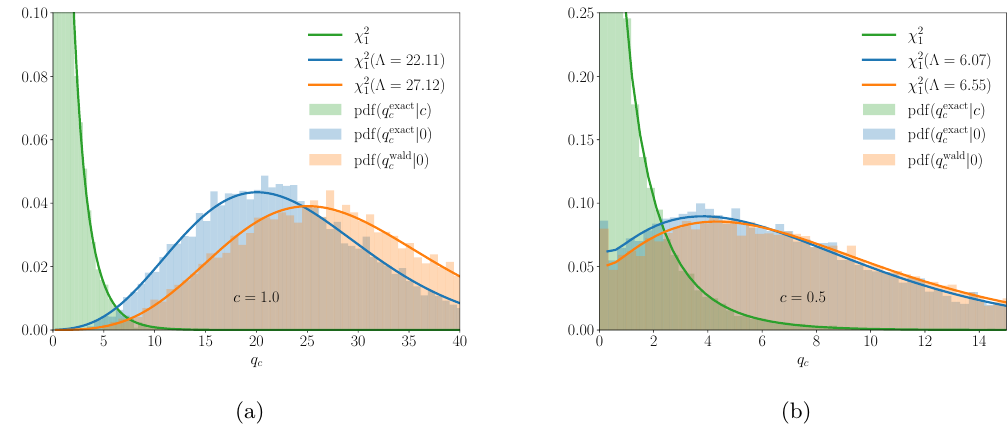
Figure 21. The distributions of q c under the EFT and the SM hypotheses for c = 1 . 0 (a) and c = 0 . 5 (b). The blue curve agrees well with the distribution pdf( q exact distribution of q c is well described by the non-central χ 2 evaluated with non-centrality parameter Λ A , unbinned . We notice a disagreement between the distribution of q exact neglecting the higher order corrections in Wald’s theorem leads to sizable differences. On the